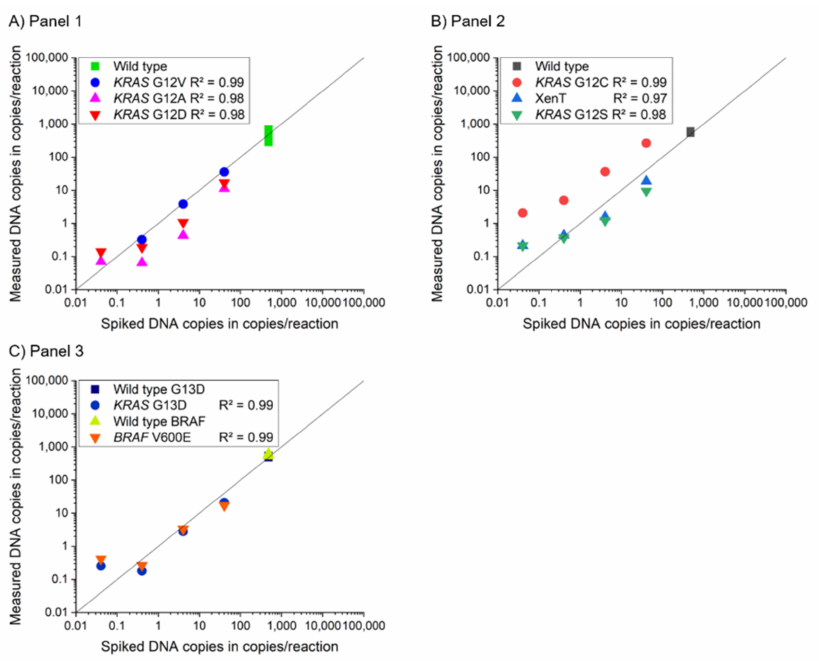
Figure 2. ( A – C ) Dilution series experiments for 4-plex MP ddPCR assays of panels 1 to 3. These assays were evaluated regarding sensitivity and linearity for each target. All assays showed a R 2 ≥ 0.97 in the range from 1 to 100 DNA copies/reaction in the spiking experiment. The lowest tested concentration (0.01 DNA copies/reaction) was used for sensitivity testing and was not included in the evaluation of the determination coefficient as the influence of the subsampling effect dominates for these low concentrations. The deviation from the expected signal for the G12S target could result from pre- analytical preparation steps (e.g., for the stock